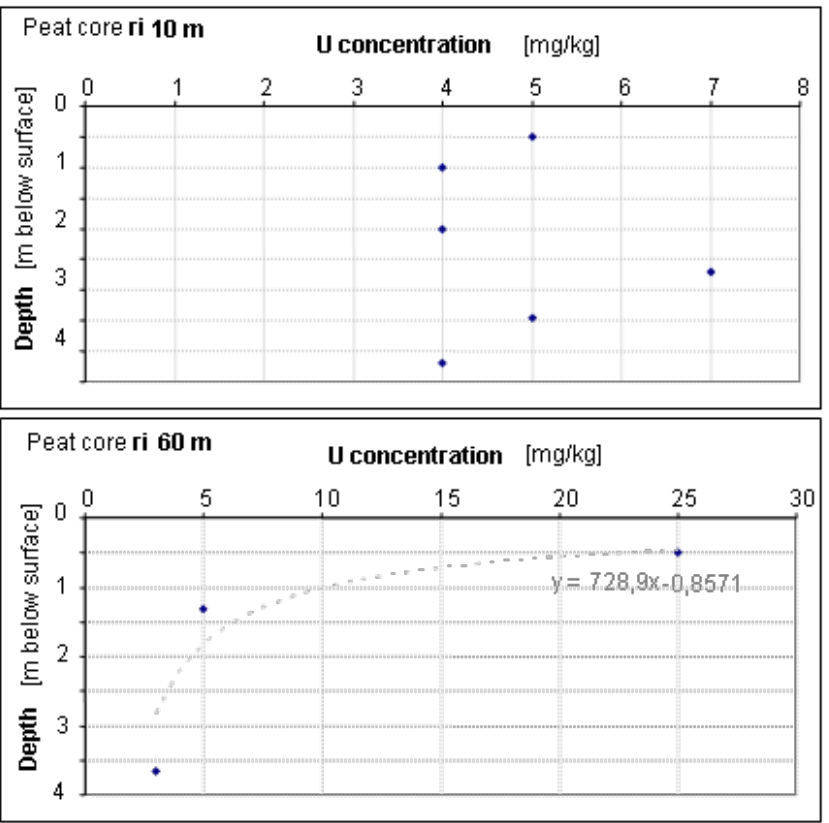
Figure 10. Vertical U distribution in near-stream peat (upper diagram, 10 m distance) and far-stream peat (lower diagram, 60 m distance) of portion